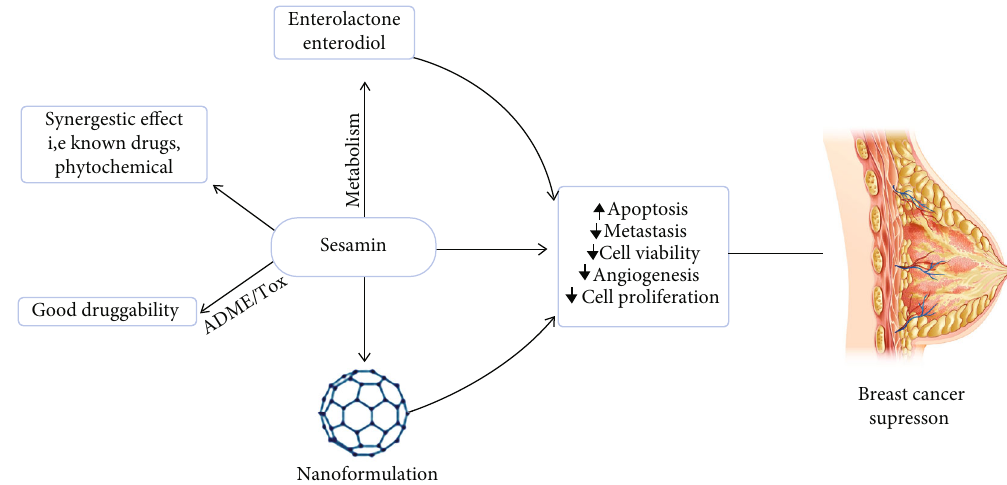
Figure 4: Summary of sesamin ’ s pharmacological properties to pharmacological insight in breast cancer